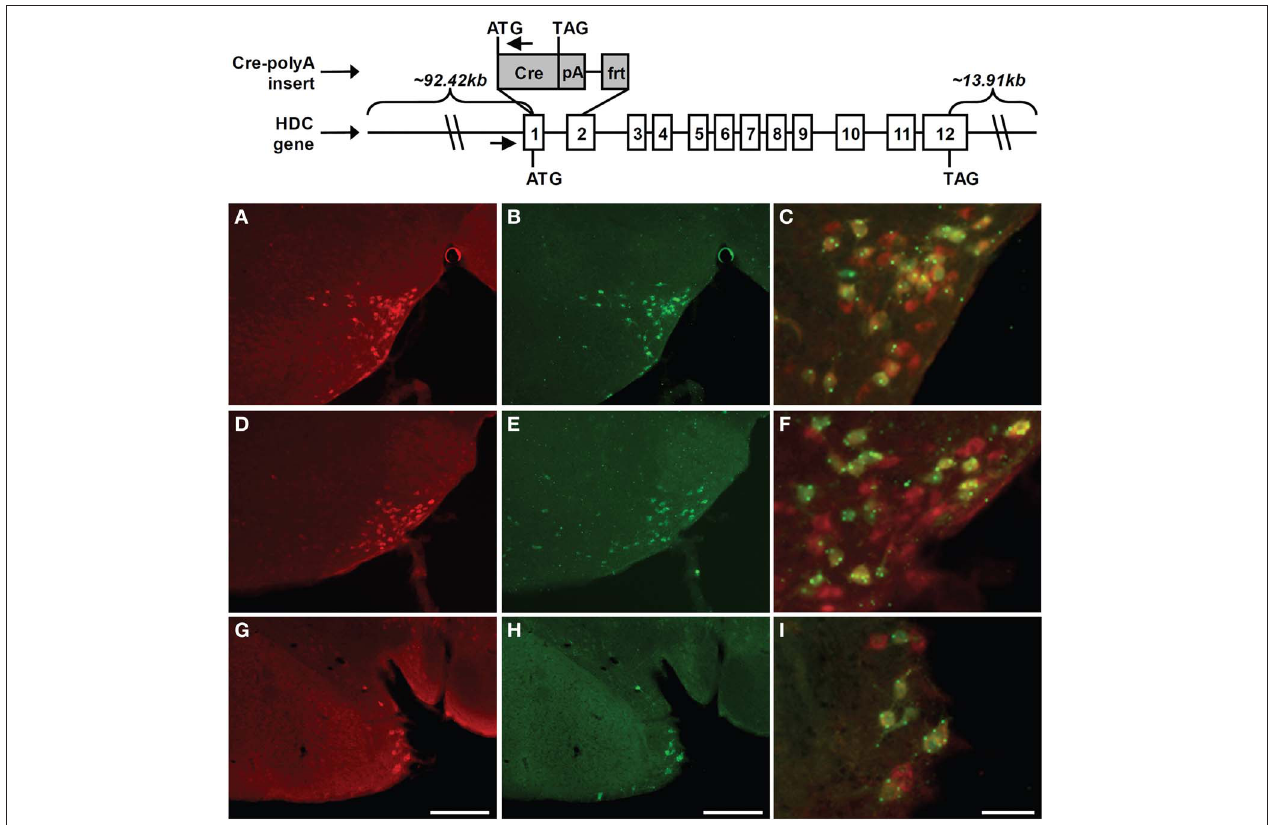
FIGURE 6 | Schematic diagram of the derivation of HDC-Cre transgenic mice and immunohistochemical analysis of transgene expression in TMN. Mice expressing Cre recombinase under the control of the HDC promoter were generated by inserting a Cre recombinase expression cassette into a BAC genomic clone containing HDC. In particular, a 2194-bp region of HDC was replaced by the coding sequence of Cre recombinase followed by an SV40 polyadenylation signal (pA) and an frt site. HDC’s exons (denoted by numbered rectangles), and the start codons (ATG) and stop codons (TAG) for HDC and Cre are all indicated. The amounts of mouse chromosomal sequence present in the BAC either upstream of the HDC start codon or downstream of the HDC stop codon also are indicated. Small arrows denote the locations of oligonucleotide primers used for genotyping.